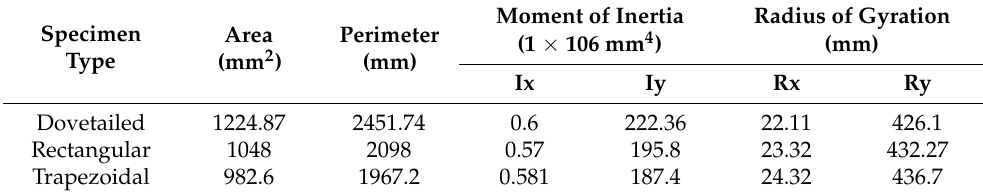
Table 3. Geometric properties of profiled sheeting.